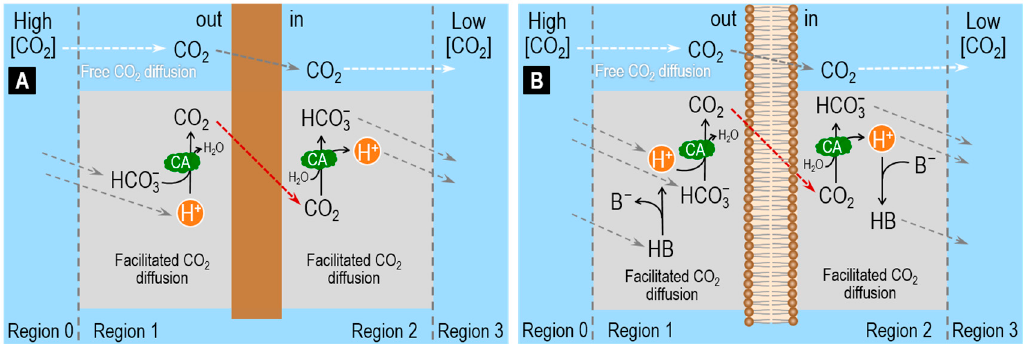
Figure 3. Schematic of the reaction and di ff usion processes involved in facilitated CO 2 di ff usion up to and away from membranes that are permeable only to CO 2 . Before time zero, we assume that all Regions have identical compositions, with all reactions being in equilibrium and no concentration gradients existing between adjacent Regions. At time zero, we establish a CO 2 gradient from Region 0 to Region 1. ( A ) Silicone rubber artificial membrane, with no bu ff ers other than CO 2 / HCO 3 − in the aqueous solutions (Broun model [80,81]). Here, the CA is attached to both sides of the membrane (“enzymatic coating”), but is present nowhere else in the system. In this system, a low level of facilitated CO 2 di ff usion—low because CA is not in the bulk solution and no non-CO 2 / HCO 3 − bu ff ers are present—would speed the appearance of CO 2 on the left side of the membrane, enhancing the gradient for CO 2 to cross the membrane. In addition, a low level of facilitated CO 2 di ff usion would speed the removal of CO 2 on the right side of the membrane, again enhancing the transmembrane CO 2 gradient. ( B ) Artificial planar lipid bilayer, with the HB / B − bu ff er pair present in both aqueous solutions, and soluble CA present throughout the aqueous solutions (Gutknecht–Tosteson model [82]). Here the facilitated di ff usion of CO 2 —from Region 0 to 1, within Region 1, from Region 1 to Region 2, within Region 2, and from Region 2 to Region 3—is faster than in ( A ) for two reasons: the presence of CA and the presence of HB / B − . Both speed CO 2 facilitated di ff usion in Regions 1 and 2. As a result, the gradient of CO 2 across the membrane—and thus the transmembrane flux—is larger in ( B ) than in ( A ).